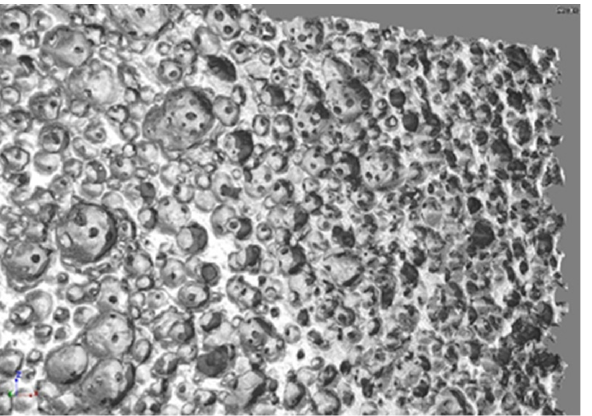
Figure 3. Microtomography image of corundum sample showing the porous surface of the biomaterial. The measurement data were analyzed using the Thermo Scientific Avizo program (version 2019.3, ThermoFisher Scientific, Waltham, MA, USA). The first stage of analysis involved data loading and displaying (Figure 4). Subsequently, the area to be analyzed was separated (Figure 5). The results of operations used in the individual methods are presented for one selected layer.